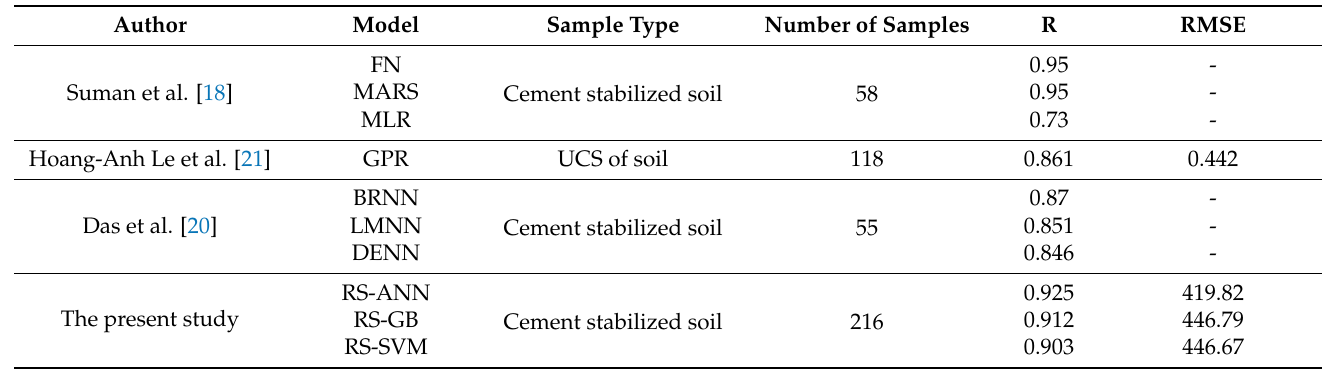
Table 7. Comparison with previous studies.